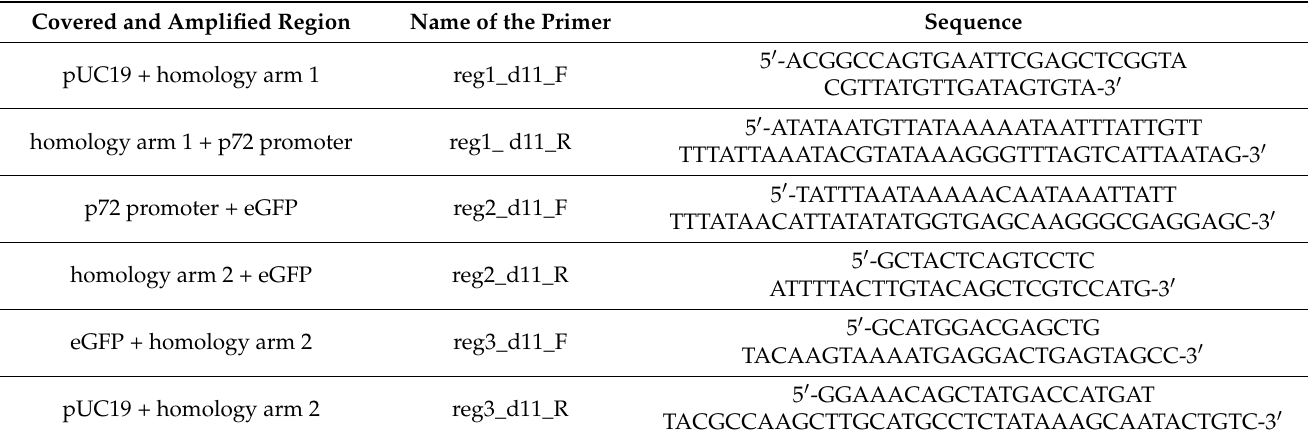
Table 1. Primers used for the amplicons to construct the transfer plasmid.